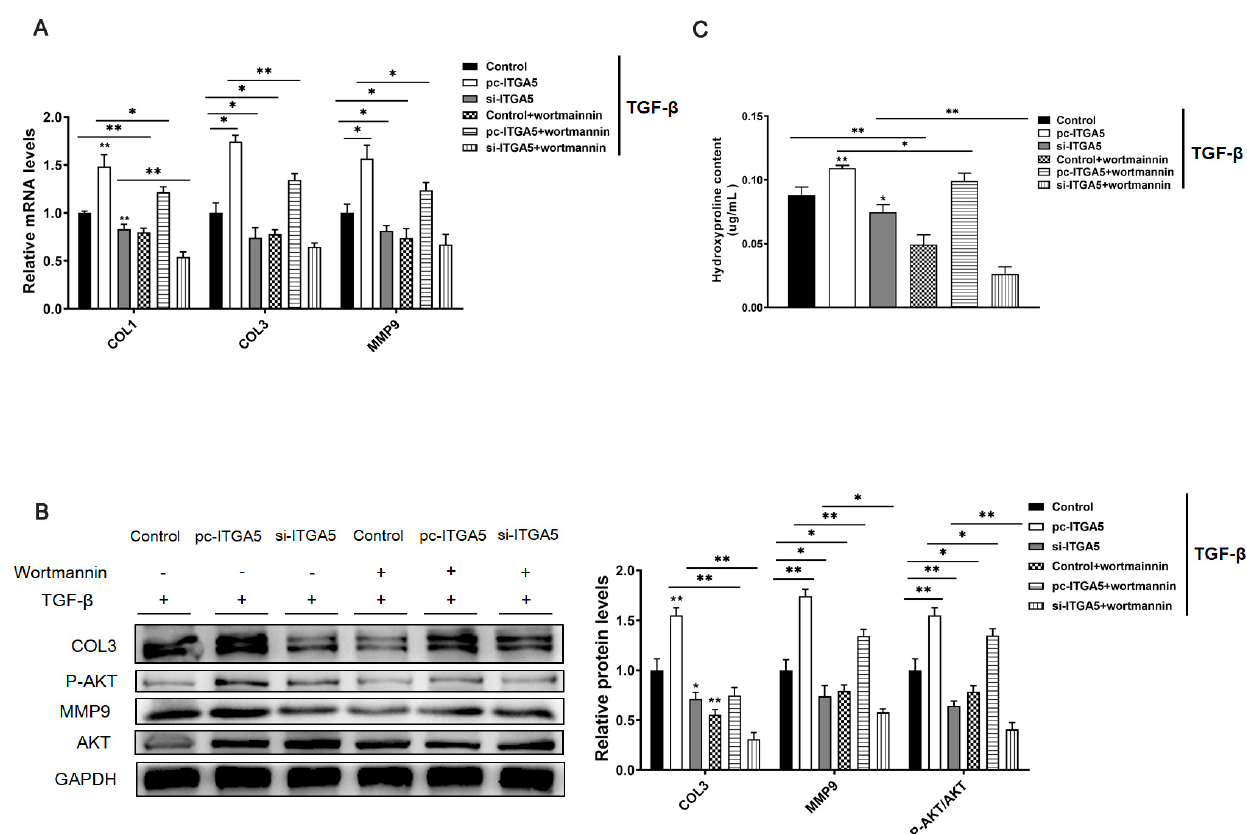
Figure 4. ITGA5 promotes adipocyte fibrosis by activating the PI3K-AKT signaling pathway. The adipocytes were treated with TGF- β to construct a cell fibrosis model. Then the adipocytes were transfected with ITGA5 overexpression vector and interference fragments, and the adipocytes were treated with wortmannin (an inhibitor of PI3K-AKT signaling pathway). ( A ) The relative mRNA expression levels of fibrosis-related genes COL1, COL3, and MMP9 ( n = 4). ( B ) The relative protein expression levels of COL3, MMP9, p-AKT, and AKT ( n = 4). ( C ) The content of hydroxyproline in adipocytes ( n = 4). n = 4 in each group. Values are means ± SD, * p < 0.05, ** p < 0.01 compared with the control group.